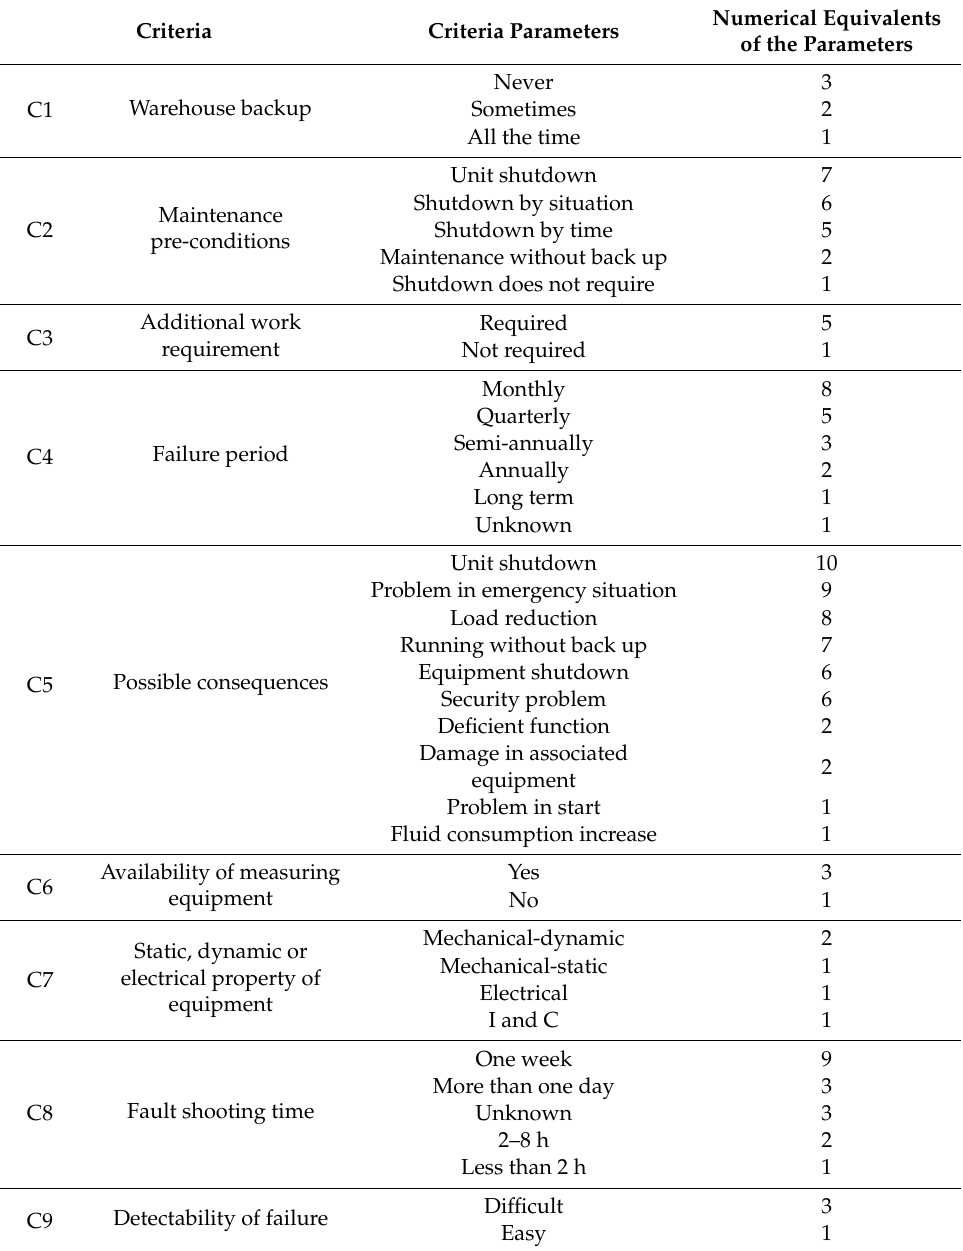
Table 5. Evaluation criteria.